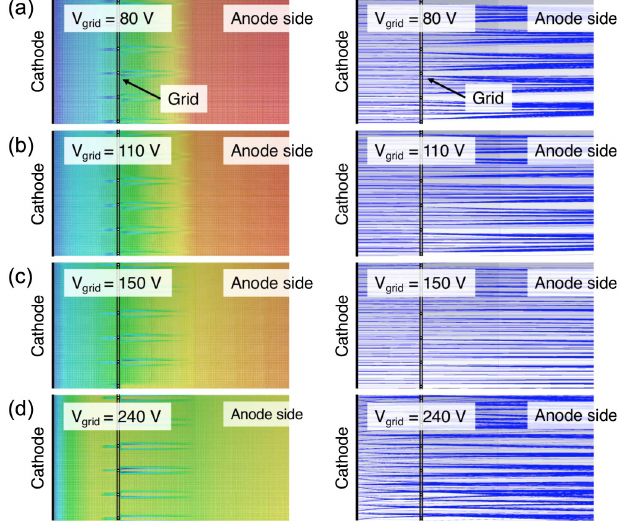
FIG. 1. Electric field distributions (left) and beam trajectories (blue lines) near the grid of Y-845 cathode (right) obtained with CST simulations. The symbols V grid represent the grid voltage and symbols (a), (b), (c), and (d) correspond to grid voltage conditions of 80, 110, 150, and 240 V, respectively. The color map shows the electric field strength (from blue at 0 V = m to red at 1 MV =